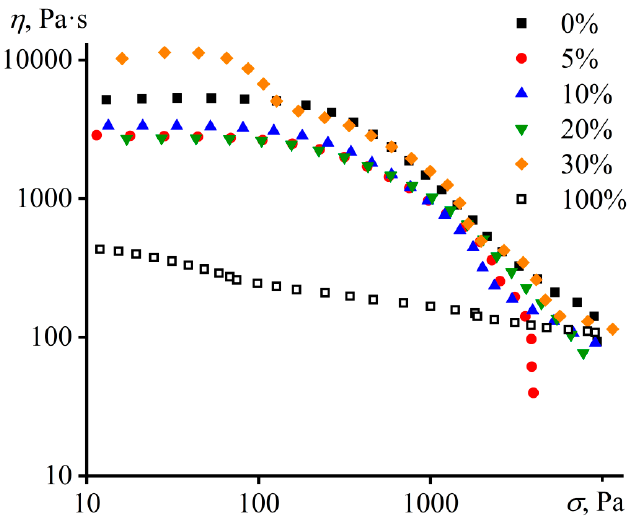
Figure 1. The dependences of viscosity on shear stress for PIB, asphaltenes, and their blends at 120 °C. The concentration of asphaltenes is shown in the legend.